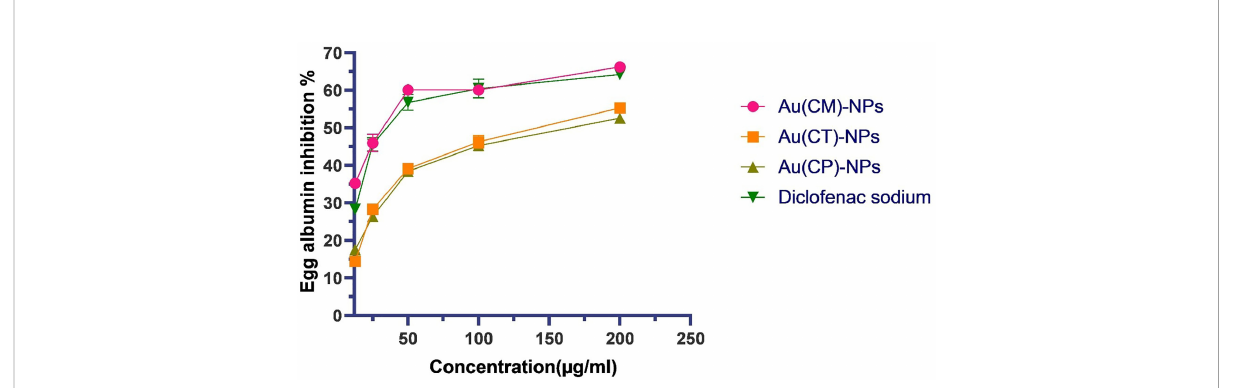
FIGURE 9 Protein denaturation (fresh egg albumin) activity of Au-NPs biosynthesized using macroalgae extracts of C. myrica Au(CM)-NPs, C. trinodis Au (CT)-NPs, C. prolifera Au(CP)-NPs and diclofenac sodium. Values refer to mean± SE.